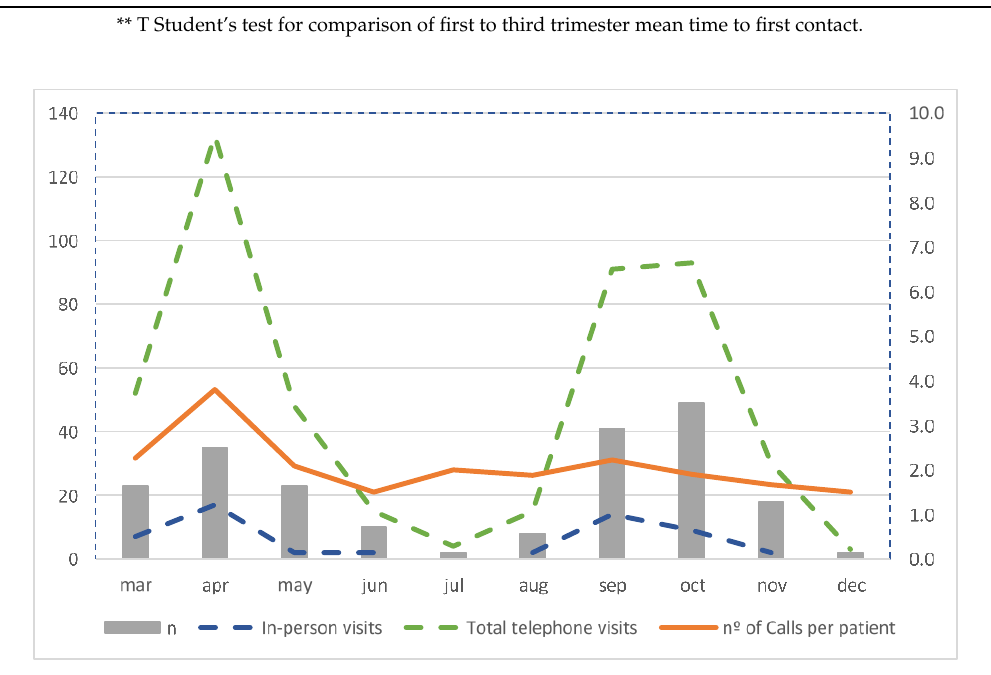
Table 4. Demographic and clinical characteristics.